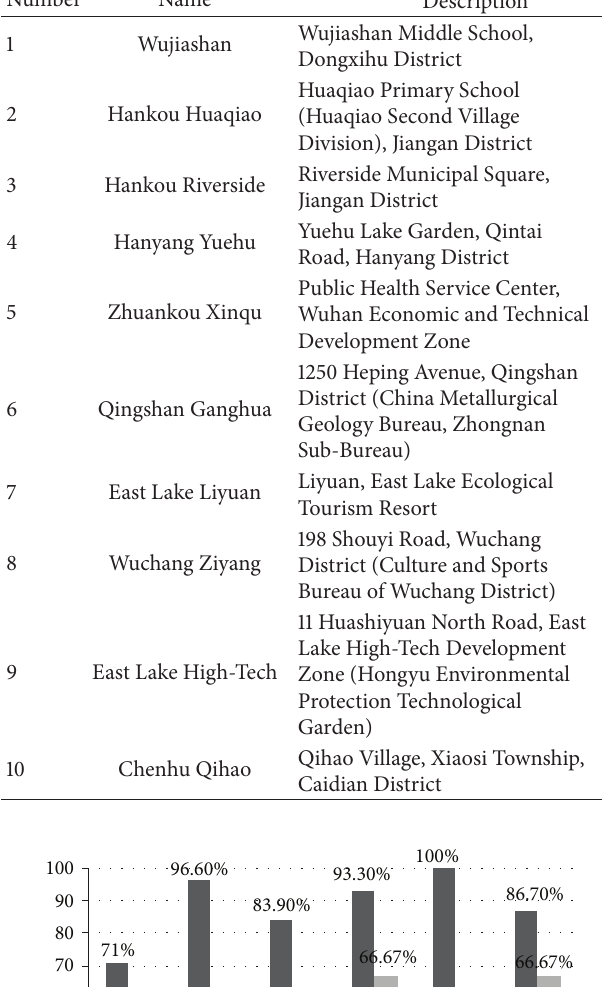
Table 1: National-level ambient air monitoring stations of Wuhan.